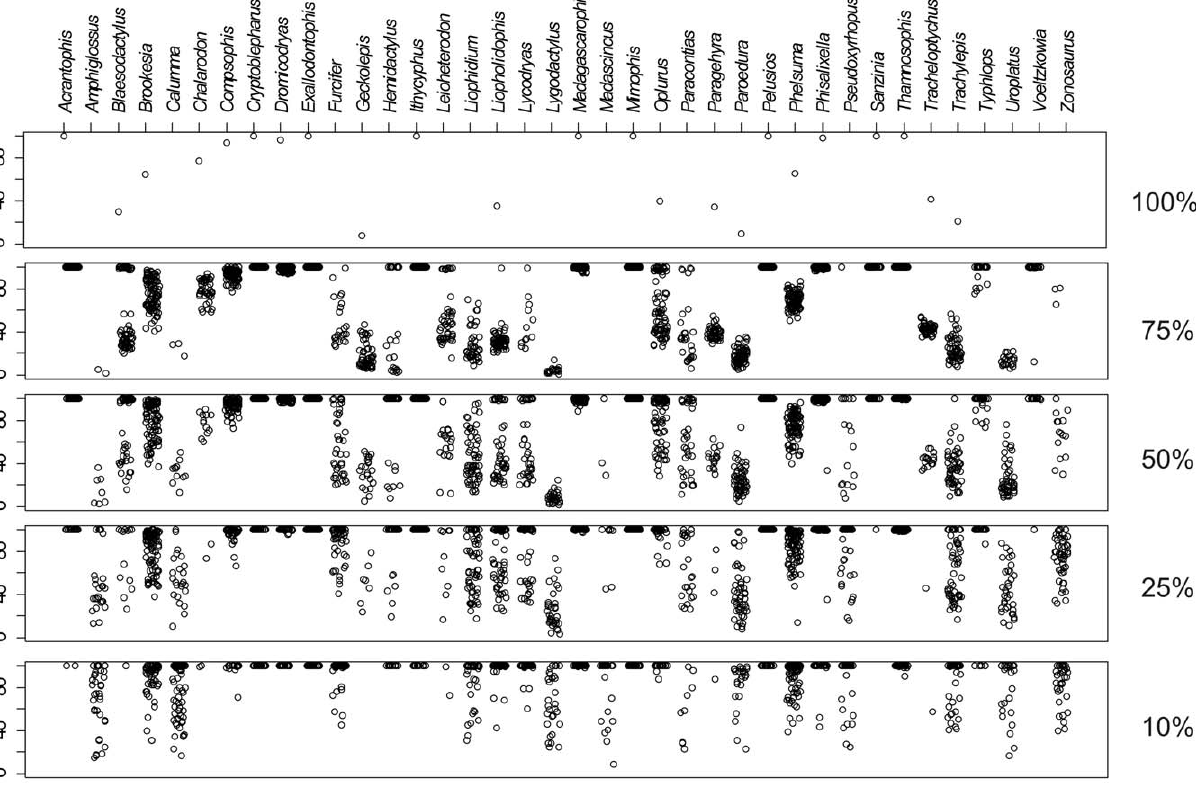
Figure 2. Plot of bootstrap values supporting monophyly of genera with different taxon sampling density. Values were obtained by neighbor-joining analyses including 100% (original data set), 75, 50, 25 and 10% (100 random subsets each) of the studied species, respectively. Support values for taxa recovered as non-monophyletic groups are not shown. doi:10.1371/journal.pone.0034506.g002 PLoS ONE |